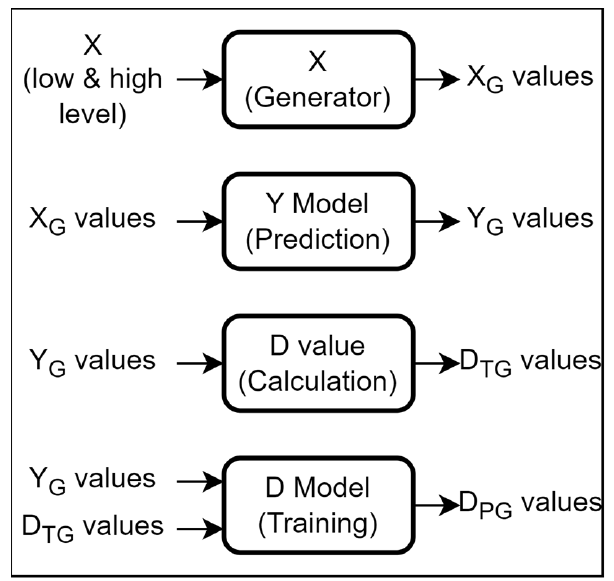
Figure 15. Steps involved in the training process of the D Model.